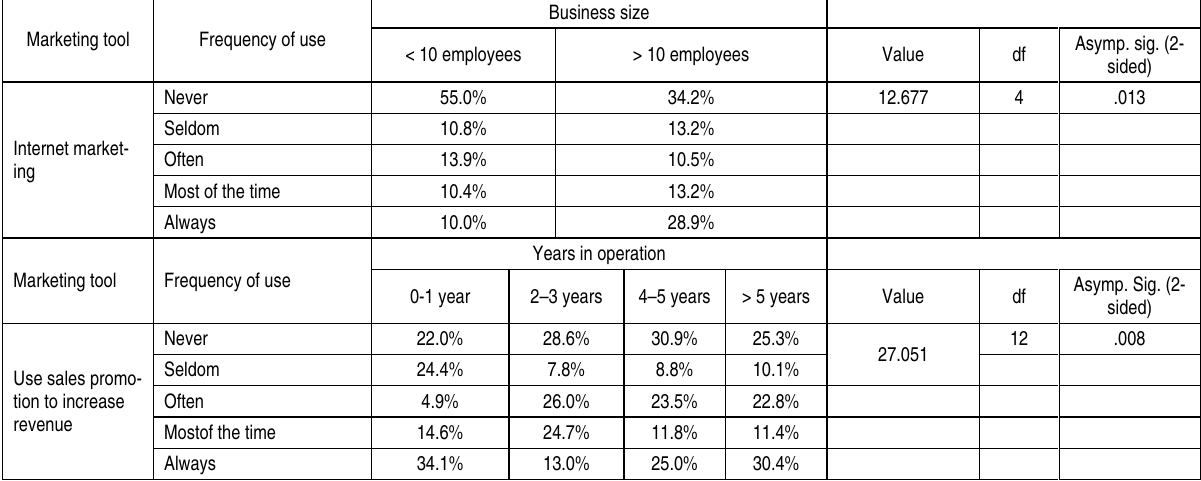
Table 3. Comparing integrated marketing communication tools with respondent profile Marketing